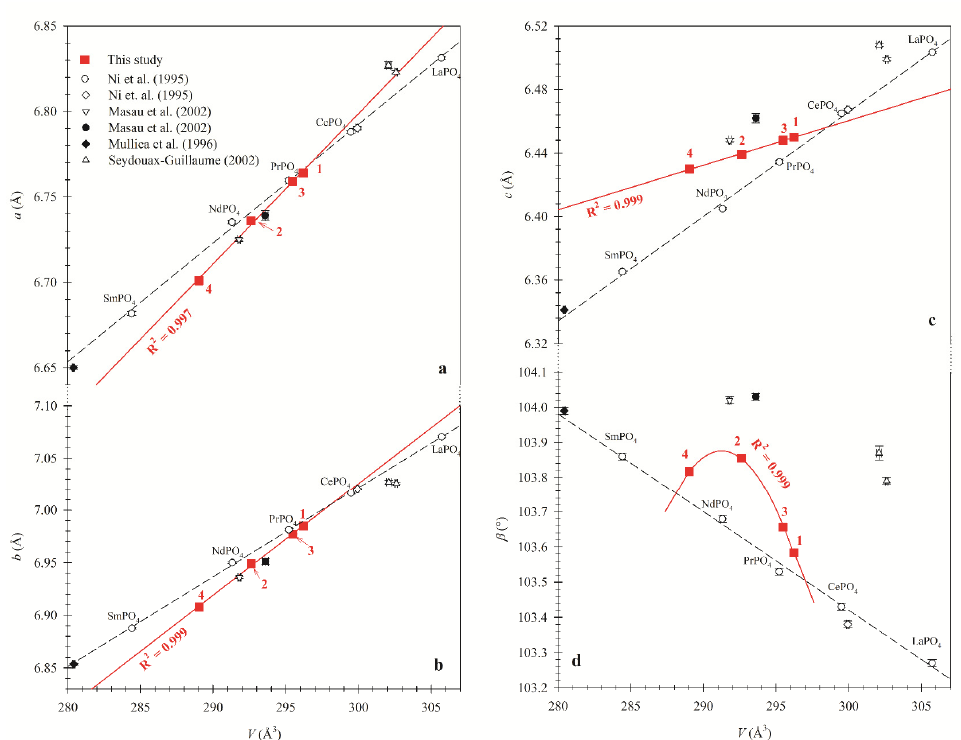
Figure 2. Variations of unit-cell parameters in monazite. The dashed linear lines are fitted to the data for the synthetic compounds LaPO 4 , CePO 4 , NdPO 4 , and SmPO 4 [8]. The a , b, and c unit-cell parameters from this study vary linearly (red lines) with V in ( a – c ) respectively, whereas the β angle in ( d ) does not vary in a linear manner. The literature data are included